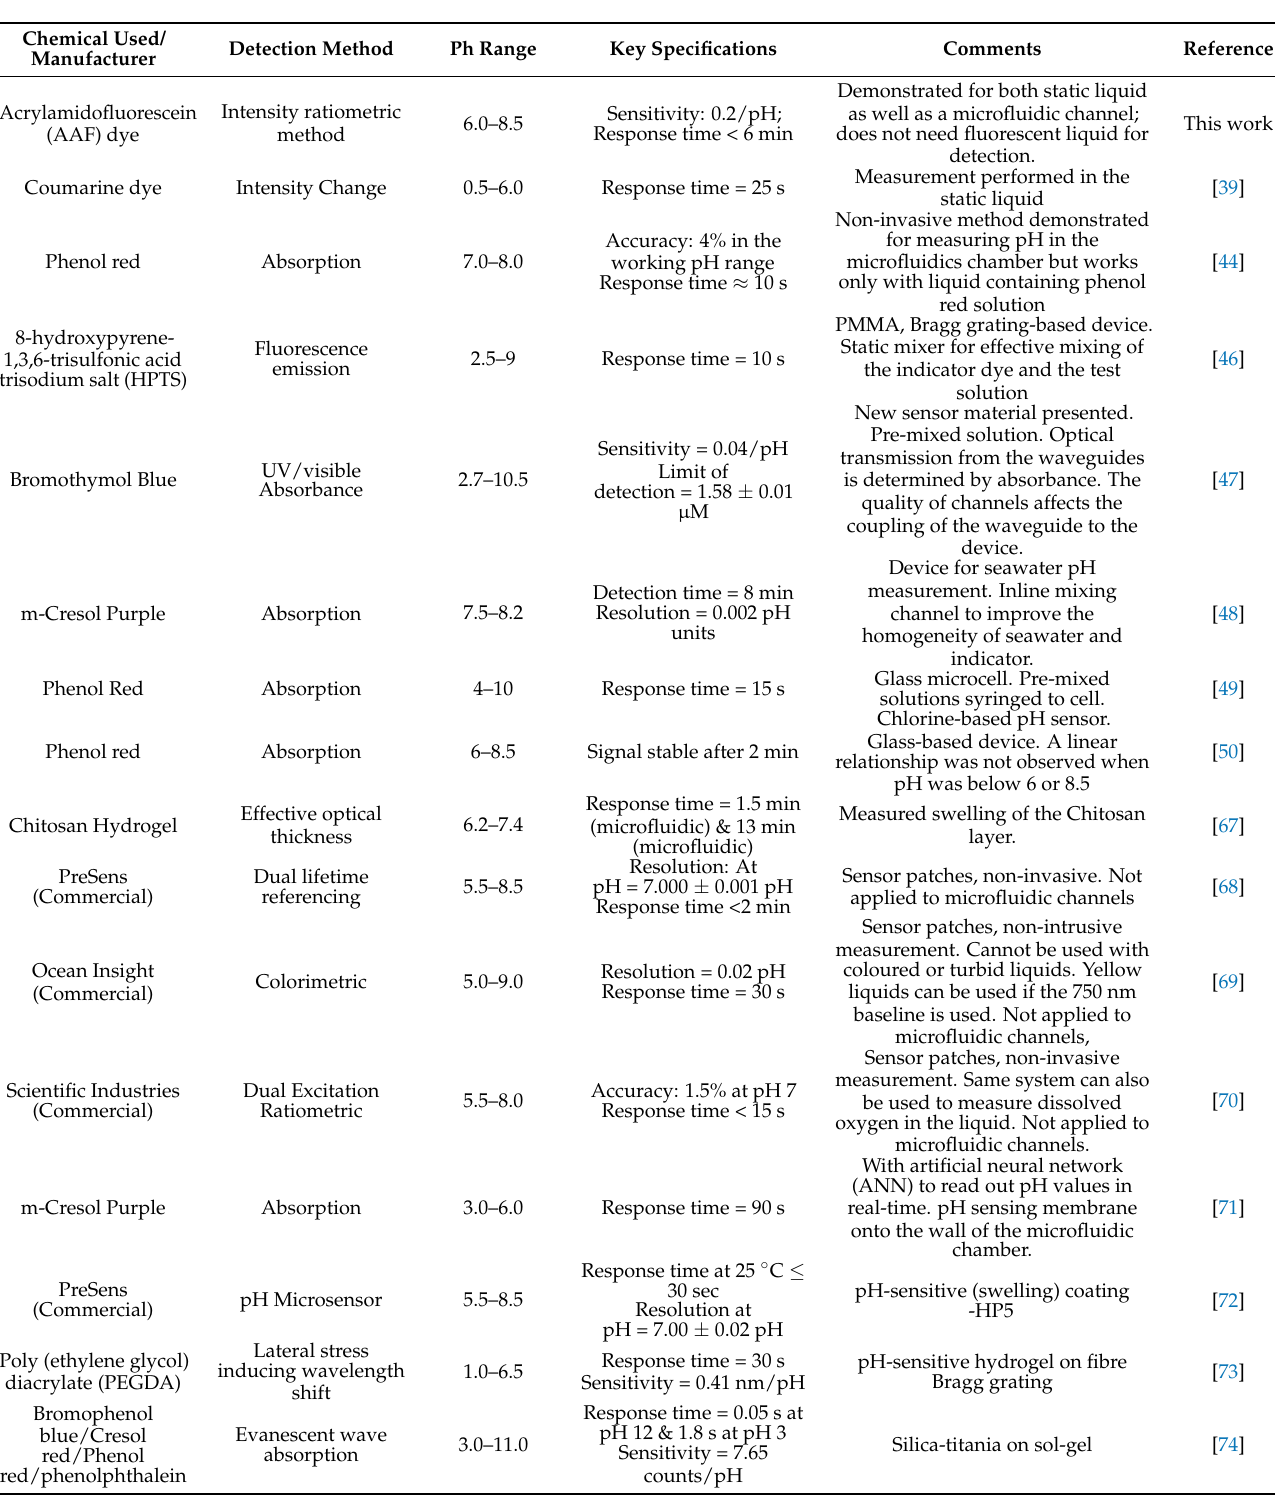
Table 1. Performance comparison with some previously reported lab-based or commercial optical chemical